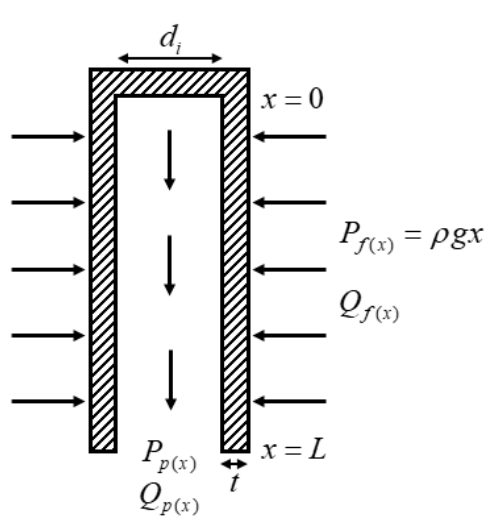
Figure 10. Theoretical model of hollow fibre within submerged membrane systems arranged in single-end bottom suction configuration.